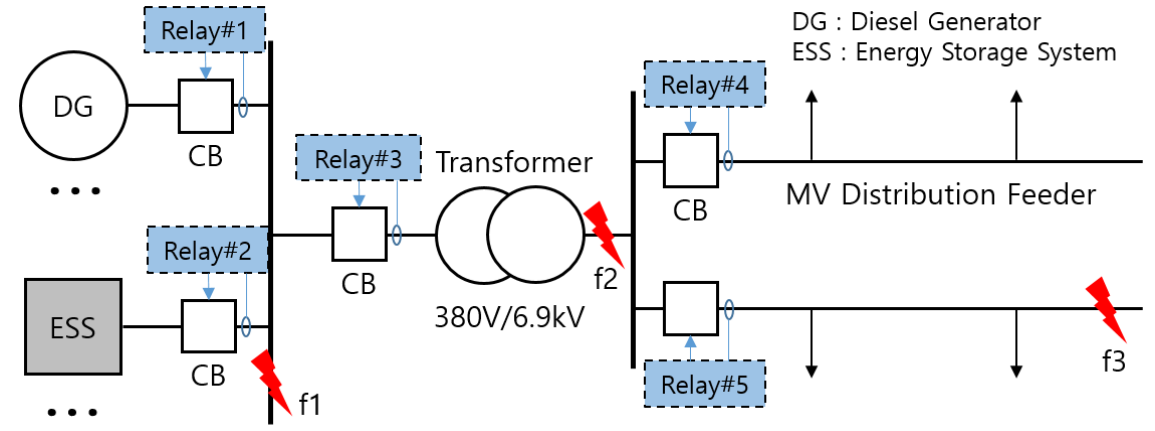
Figure 1. Several over current relay at single bus isolated microgrid.